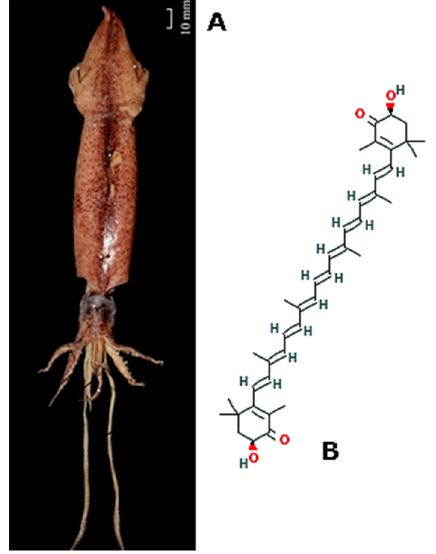
Figure 15. ( A ) A specimen of Uroteuthis singhalensis ; http: // www.borneomolluscs.com. ( B ) 2D structure Figure 15. A ) A specimen of Uroteuthis singhalensis ; http://www.borneomolluscs.com. B ) 2D of astaxanthin; https: // pubchem.ncbi.nlm.nih.gov / compound / Astaxanthin#section = structure of astaxanthin; https://pubchem.ncbi.nlm.nih.gov/compound/Astaxanthin#section= 2D-